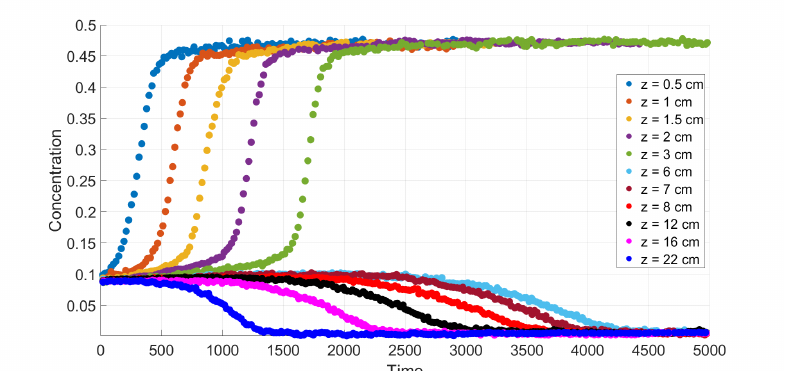
Figure 4. Experimental data for mean concentration versus time at different heights in the case of a Newtonian fluid [4].